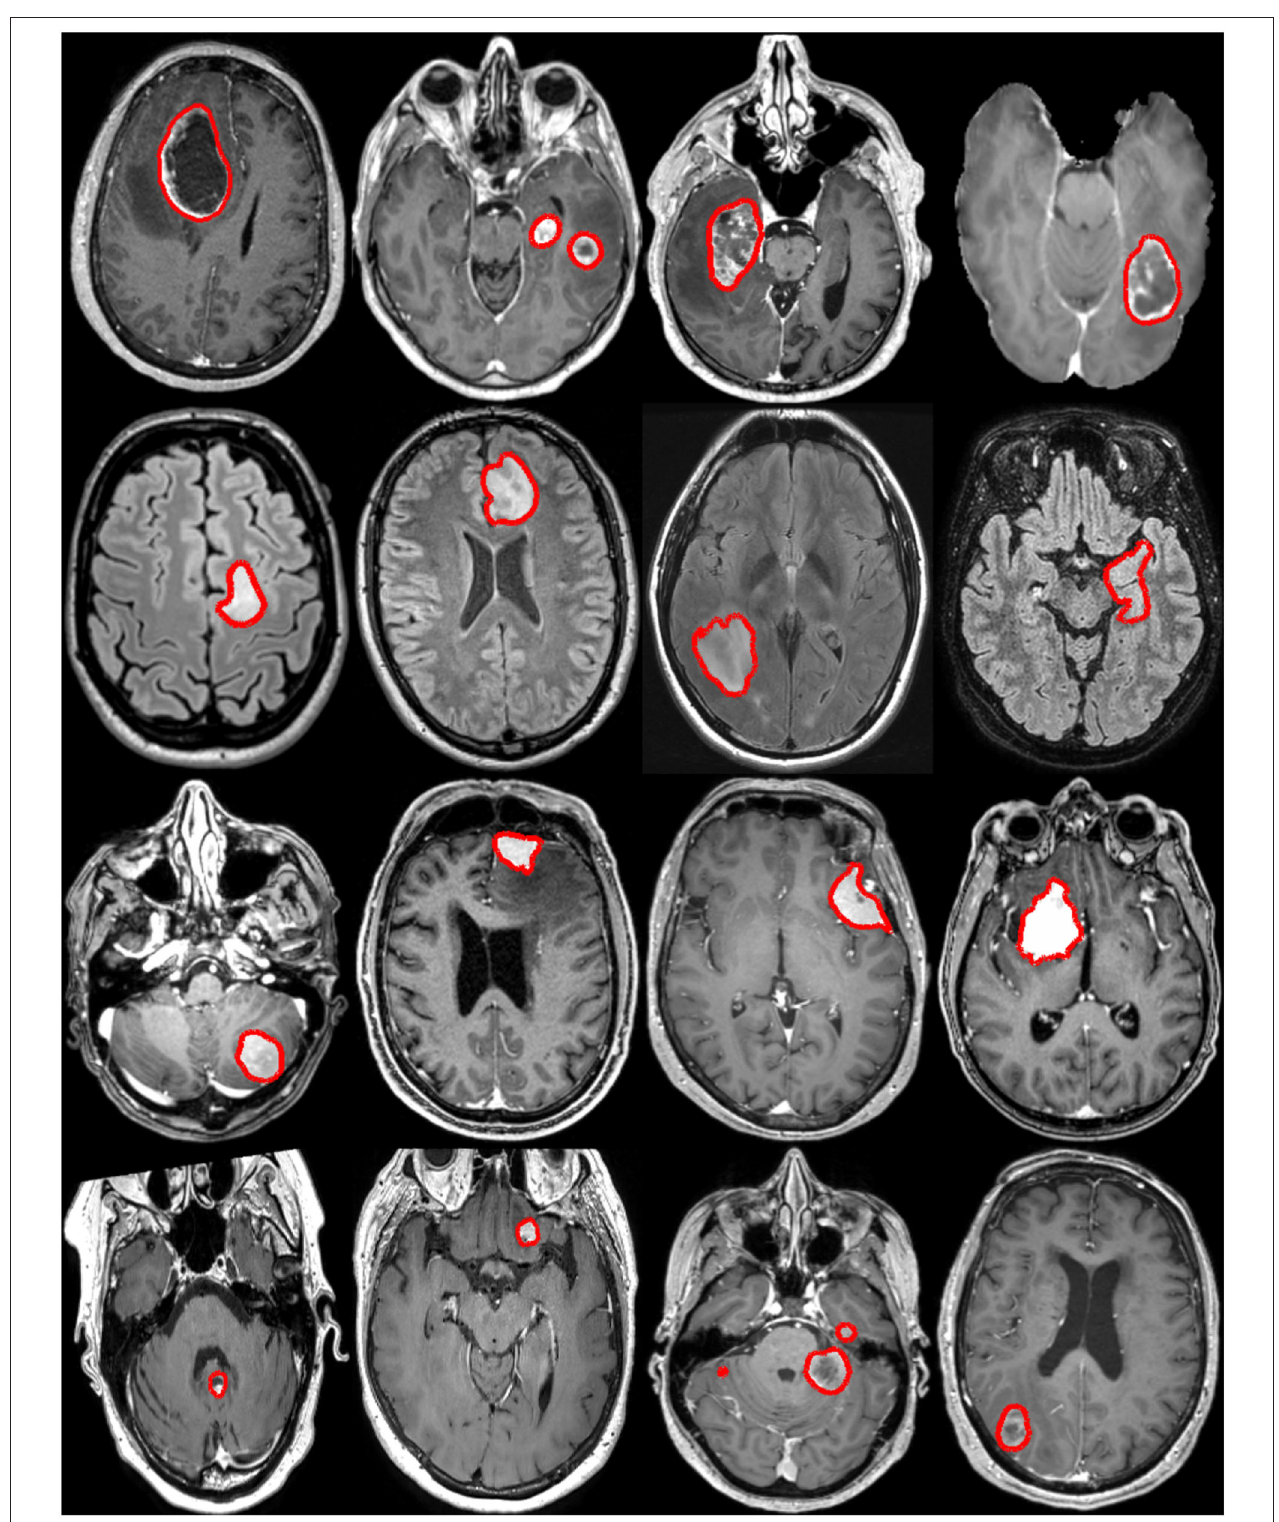
FIGURE 1 | Examples of brain tumors from the raw MRI volumes collected in this study. Each row illustrates a tumor type: glioblastoma, lower grade glioma, meningioma, and metastasis (from top to bottom). The manual annotation contours are overlaid in red.